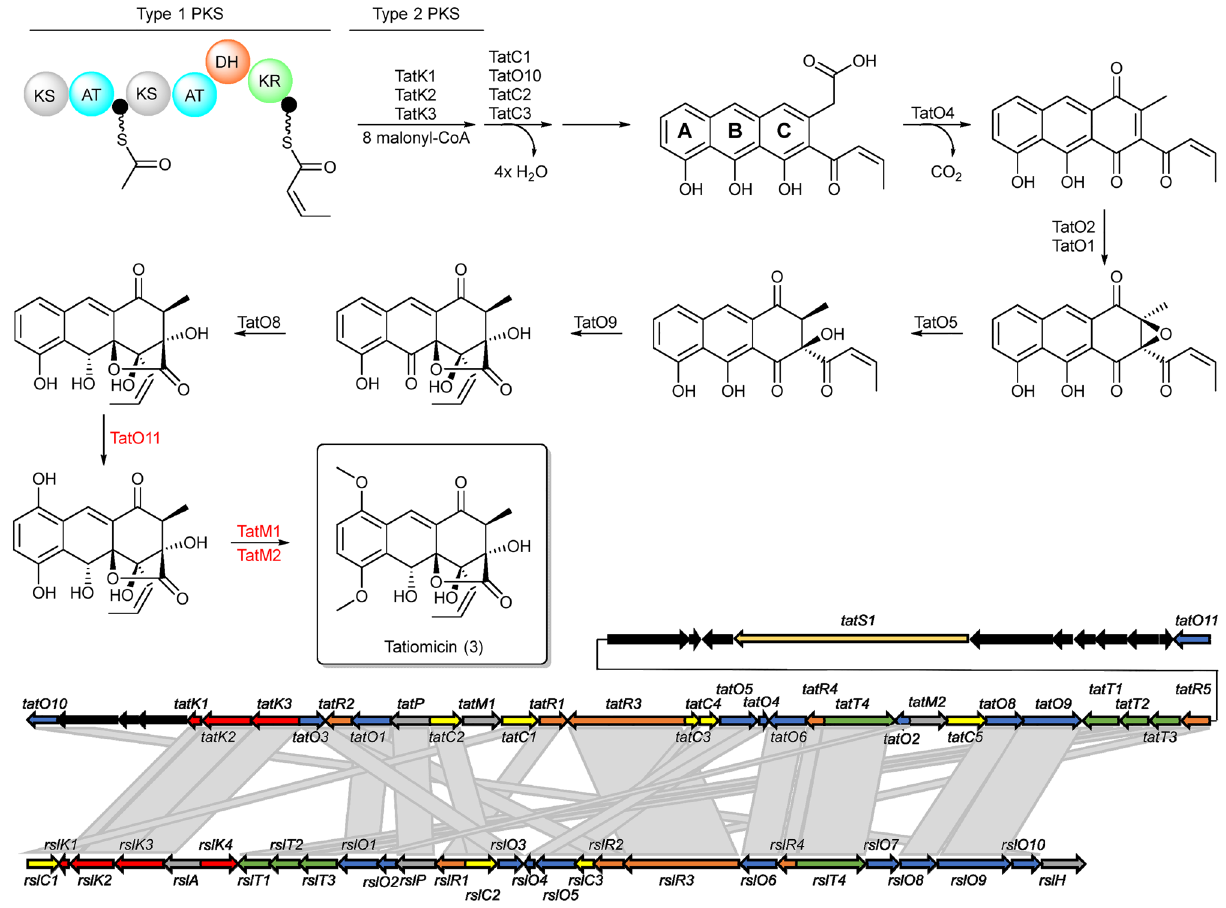
Figure 6. Top) Proposed pathway for the biosynthesis of (–)-tatiomicin ( 3 ) based on homology with the biosynthetic gene cluster for the rishirilides. Enzymes shown in red have no direct congener in the rishirilide BGC and their biosynthetic role is hypothesised, based on BLAST analysis. Bottom) comparison of the rishirilide and (-) tatiomicin gene cluter based on BLAST analysis. (red; tatS = starter unit biosynthesis, tatK or rslK = chain biosynthesis), polyketide modification (blue; tatO or rslO = oxidoreductases, tatC or rslO = cyclases), regulation (yellow; tatR or rslR), transport (green, tatT or rslT) and others (grey; tatP or rslP = phosphorylase; tatM = methyltransferases, black; genes not assigned to the tatiomicin BGC based on homology to the rishirilide BGC and proposed biosynthetic